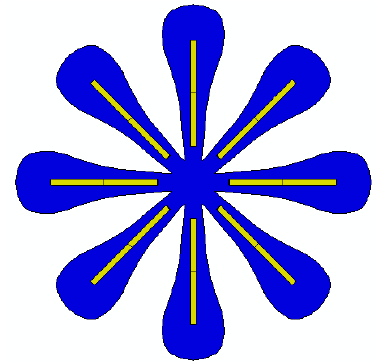
Figure 13. Undeformed configuration of a flower-shaped structure.